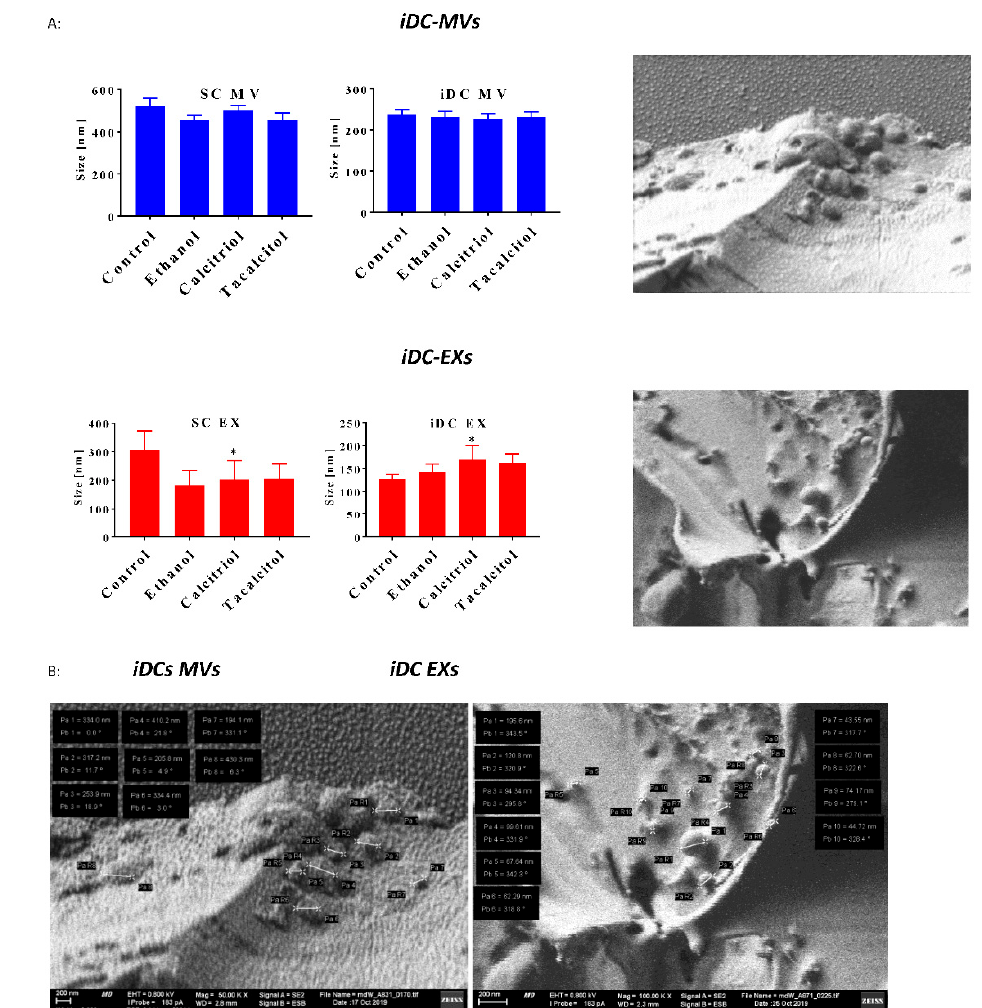
Figure 6. Size distribution of microvesicles (MVs) and exosomes (EXs) derived from parental monocytes and myeloid-derived iDCs: ( A ) size distribution of MVs/EXs-derived from parental cells/iDCs. Mean values and standard deviation are presented. Statistical analysis: Sidak’s multiple comparisons tests were performed. Significant differences compared with ethanol are marked in the figure; (* p < 0.005). The graphs represent data from the three-to-six consecutive measurements of at least three separate collected samples taken with an acquisition time of 30 sec per correlation function; ( B ) freeze–fracture distribution of MVs/EXs derived from iDCs (control). iDCs-derived MVs (control): magnification, 50,000×; field of view, 6 μ m; iDCs-derived EXs (control): magnification, 100,000×, field of view, 3 μ m).